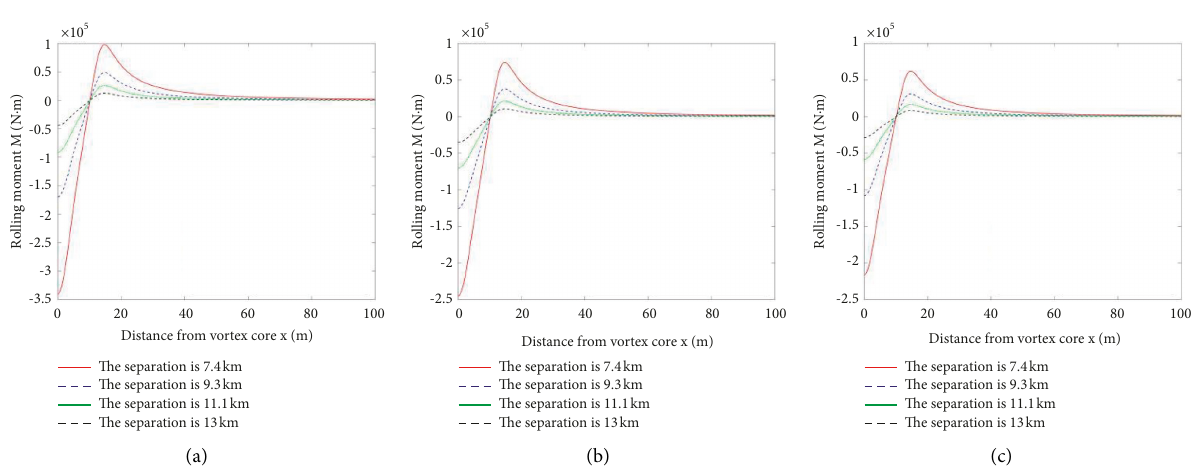
Figure 9: Variation of rolling moment when encountering a single wake vortex. (a) Takeoff phase. (b) Level flight phase. (c) Landing phase.